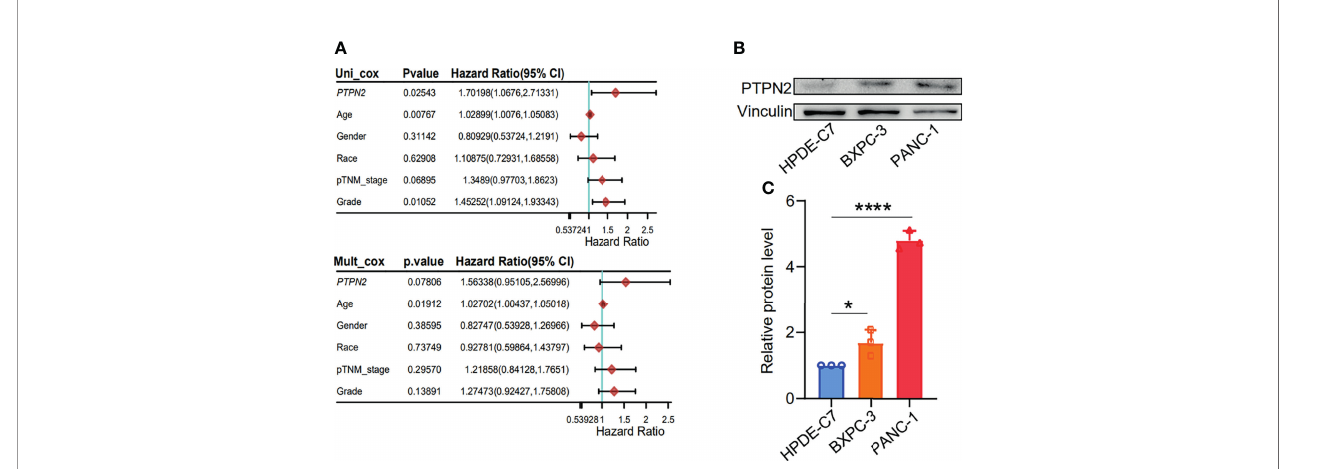
FIGURE 6 | Increased PTPN2 expression is associated with the prognosis of pancreatic adenocarcinoma. (A) Univariate regression analysis of clinical information in TCGA PAAD samples. (B) The protein levels of PTPN2 were detected by western blot analysis in PAAD cells. vinculin was used as an endogenous control. (C) Grayscale analysis of the western blot results. *p < 0.05, ****p < 0.0001.